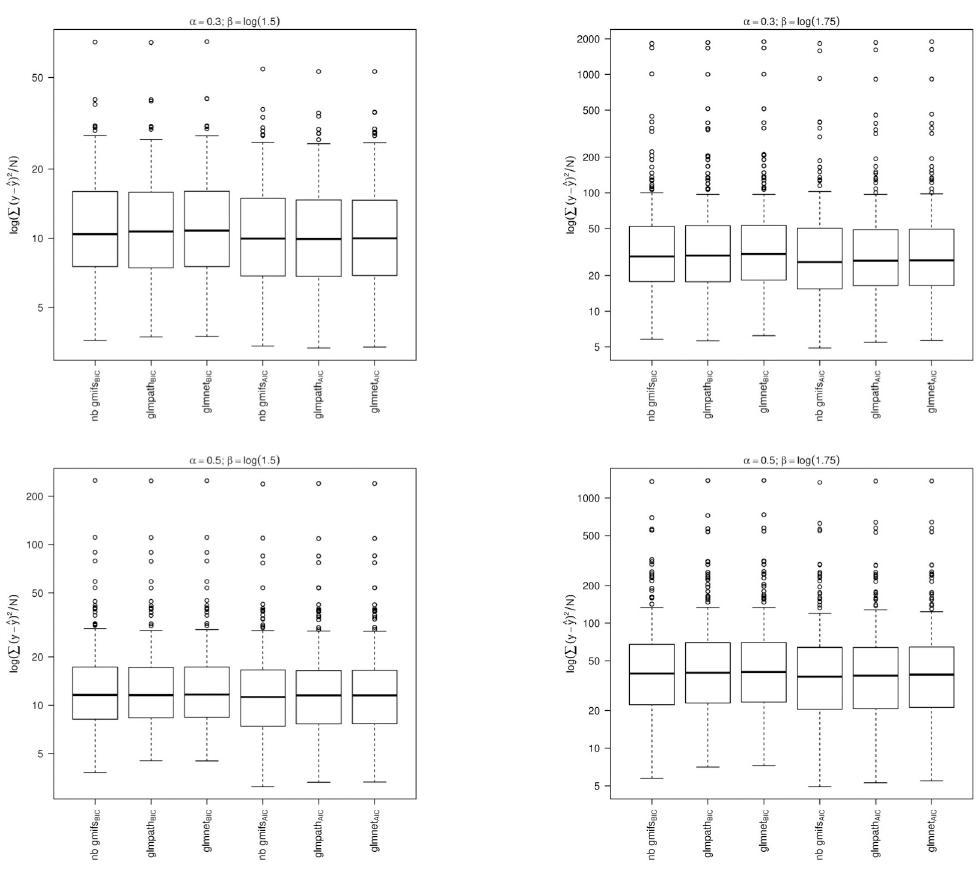
Fig 5. Prediction error for each modeling method and selection criteria. A: α = 0.3; β = ± log(1.5). B: α = 0.3; β = ± log (1.75). C: α = 0.5; β = ± log(1.5). D: α = 0.5; β = ± log(1.75).